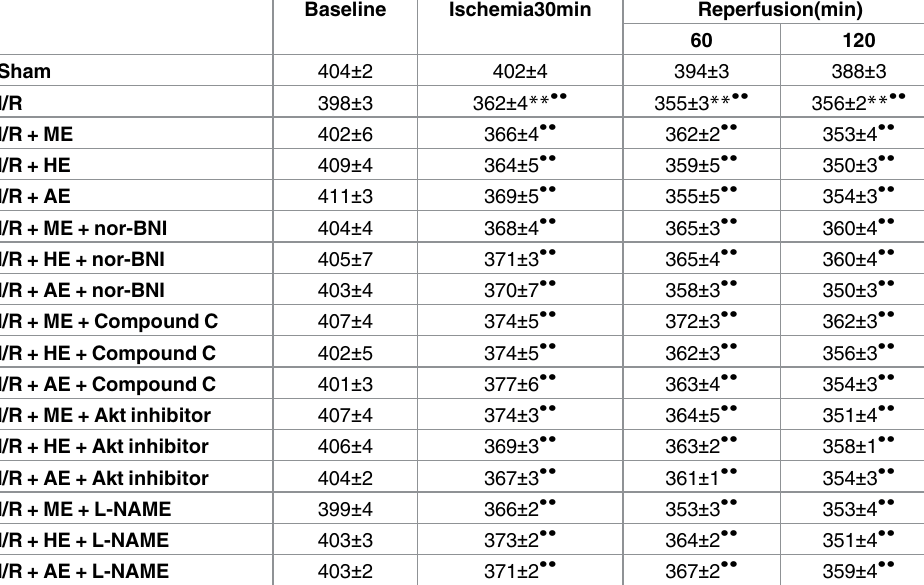
Table 1. Changes in heart rate (bpm) during myocardial